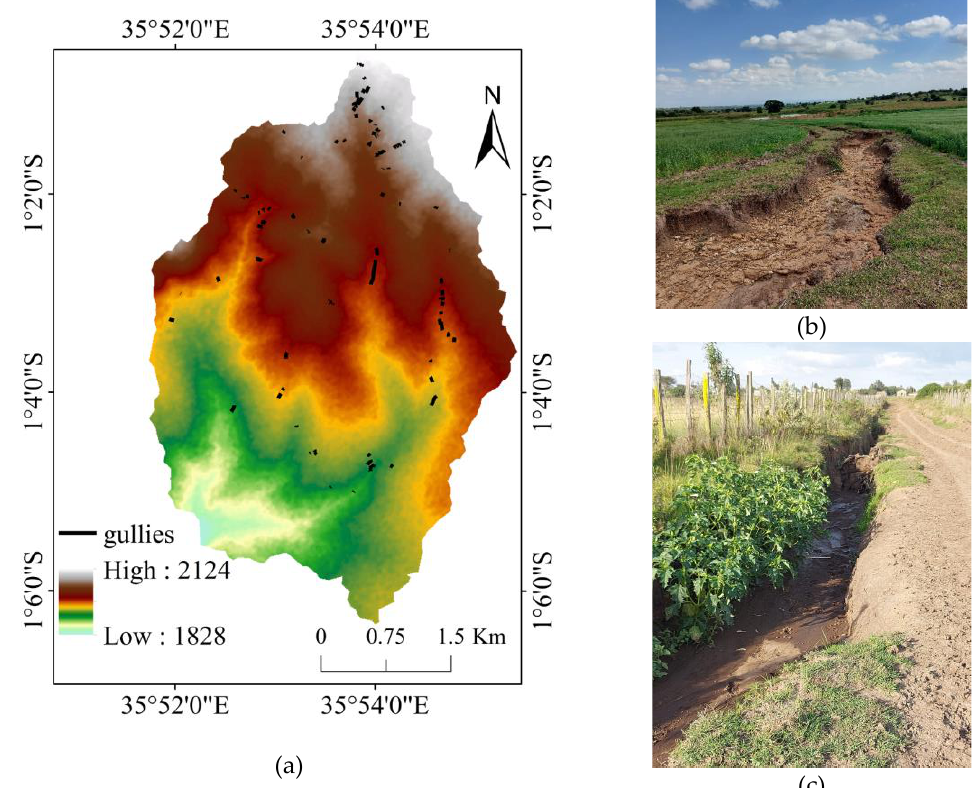
Figure 3. Map of the observed gullies ( a ) and pictures of some of the gullies identified in the Kakia-Esamburmbur catchment ( b , c) .